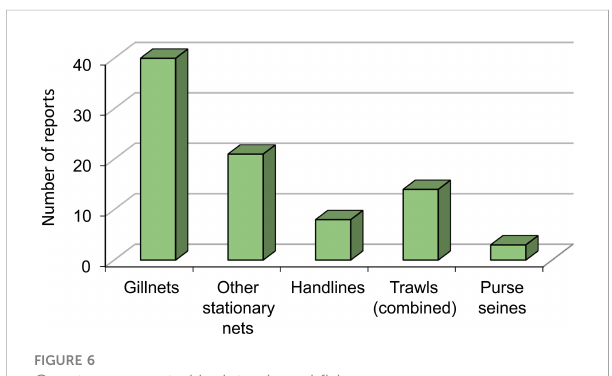
FIGURE 6 Gear types reported by interviewed fi shermen.